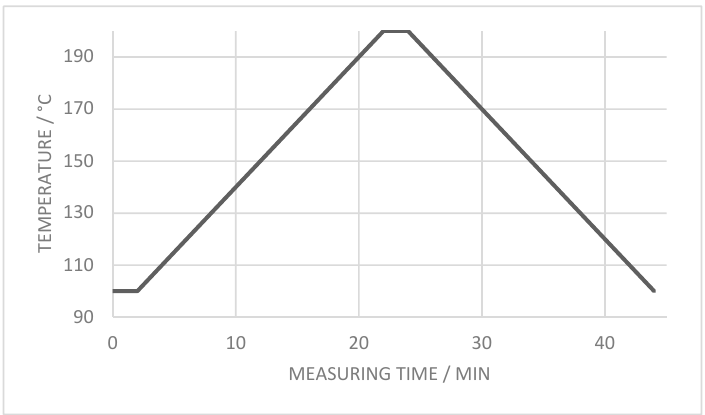
Figure 2. Schematic temperature program used in differential scanning calorimetry measurements for melting and crystallization behavior.